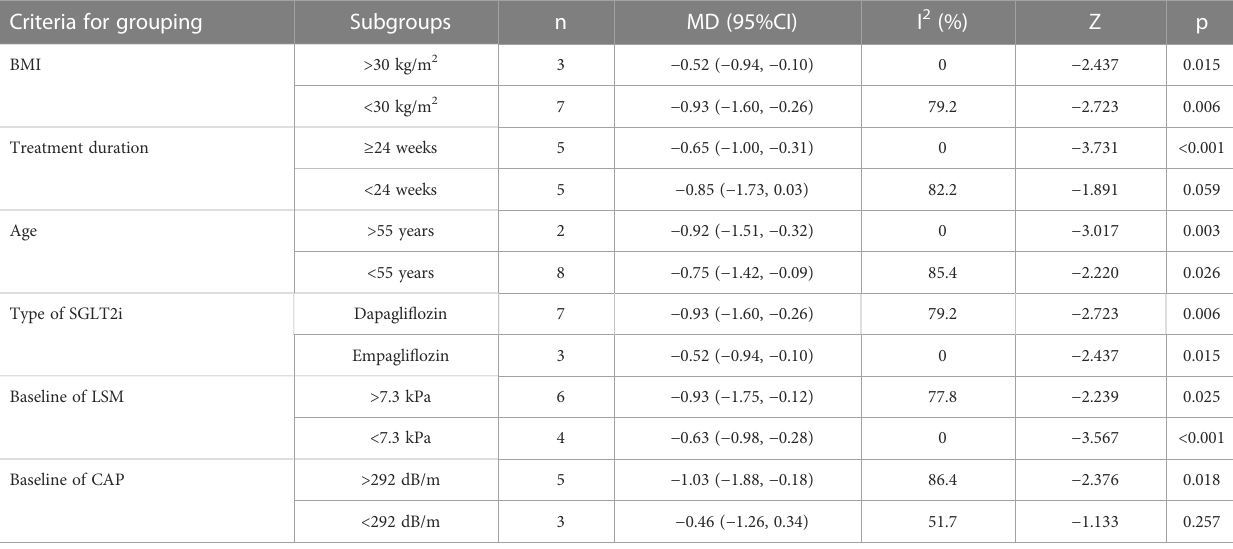
TABLE 2 Subgroup analyses of LSM based on BMI, treatment duration, age, type of SGLT2i, and baseline of LSM and CAP. Criteria for grouping